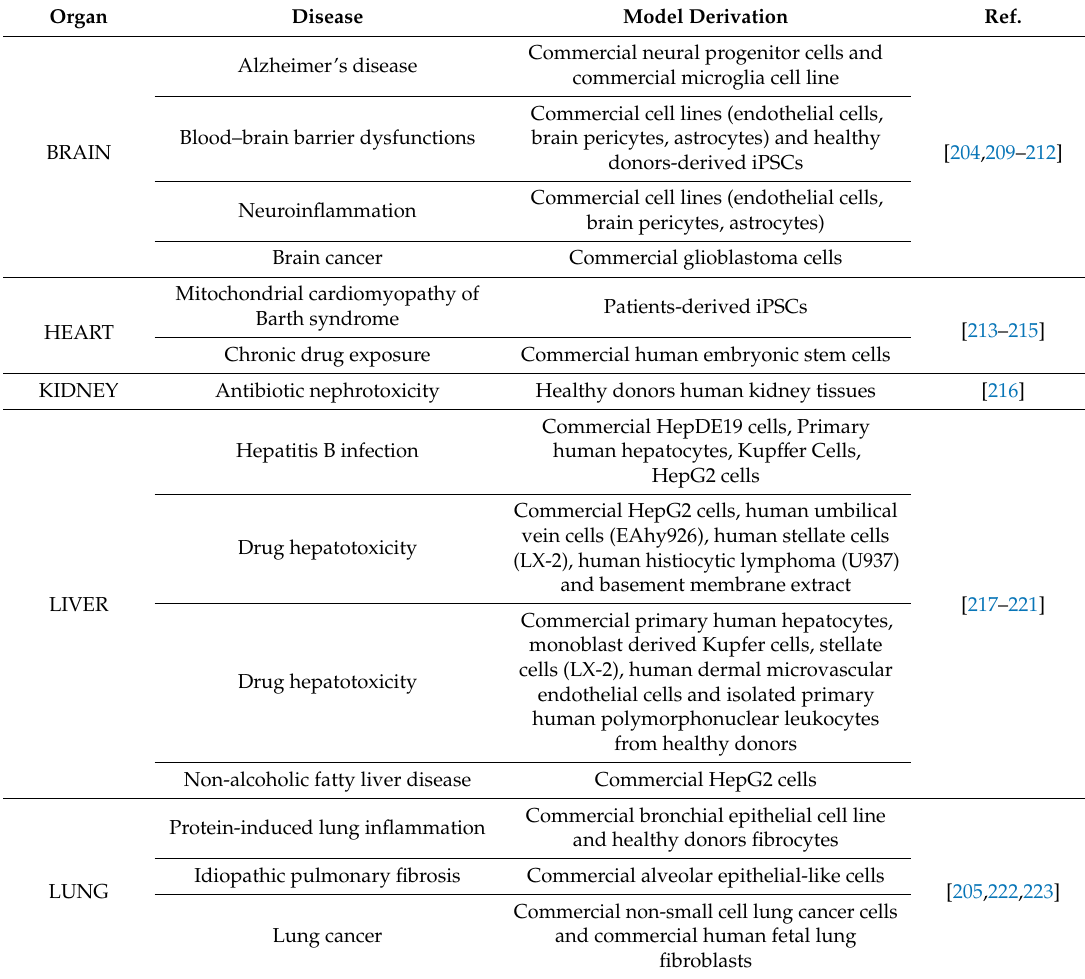
Table 6. List of human organ-on-a-chip disease models. Organ Disease Model Derivation